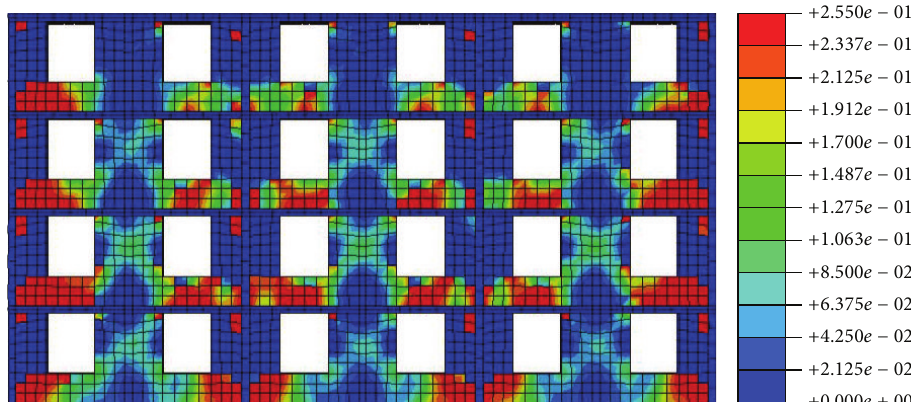
Figure 29: Tension crack damage cloud of model 1 under Lixian County ground motion.